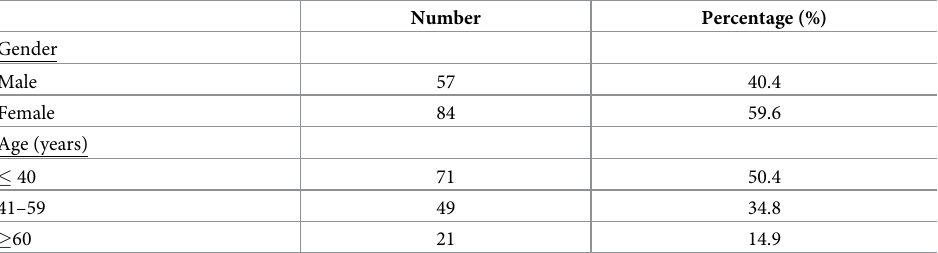
Table 1. Gender and age of the study participants.